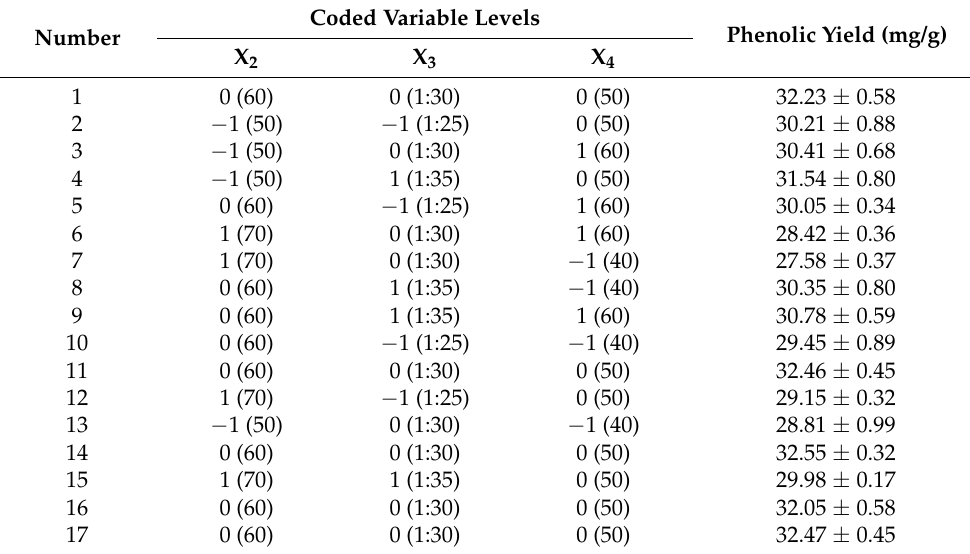
Table 3. Box–Behnken design and results.